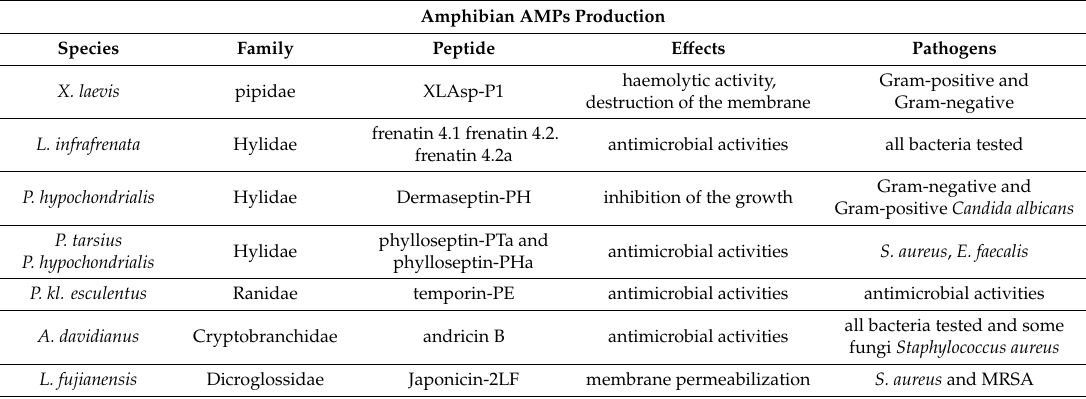
Table 1. Schematic representation of some AMP extracted by